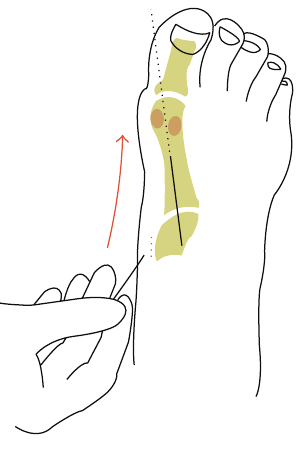
Figure 1: A 2.7 mm low-profile plate is slid minimally invasively through a proximal incision to achieve normal abduction of the medial column.